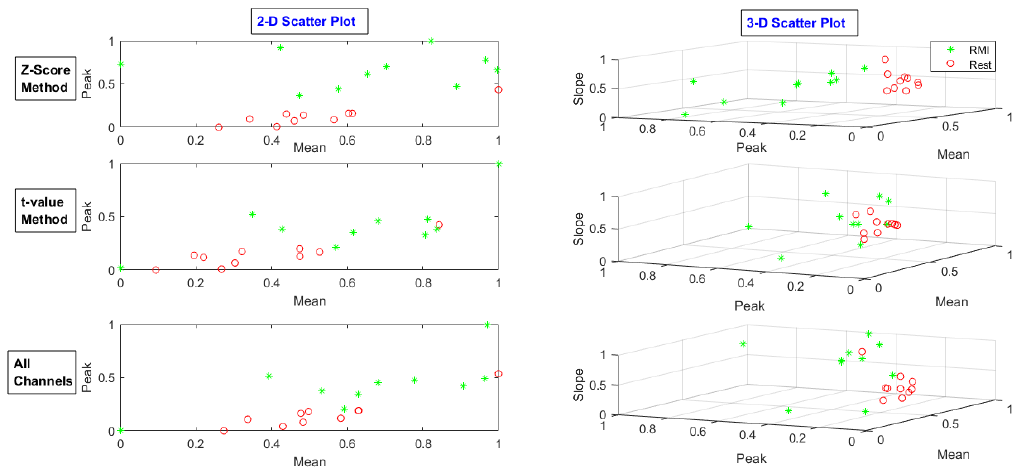
Figure 1. Experimental paradigm for data acquisition. After the initial 60-s rest, a single trial consisted